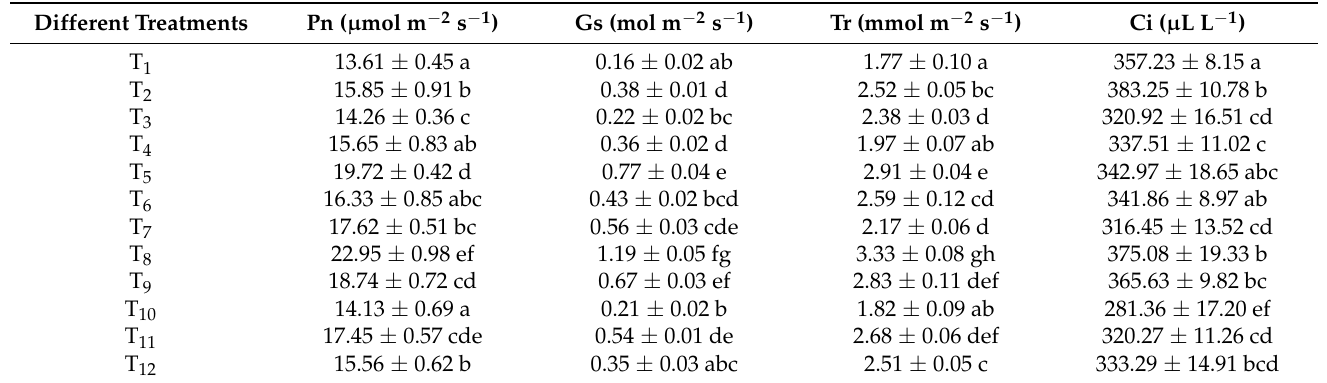
Table 2. Effect of different EF-Cd treatments on photosynthetic parameters in L . japonica